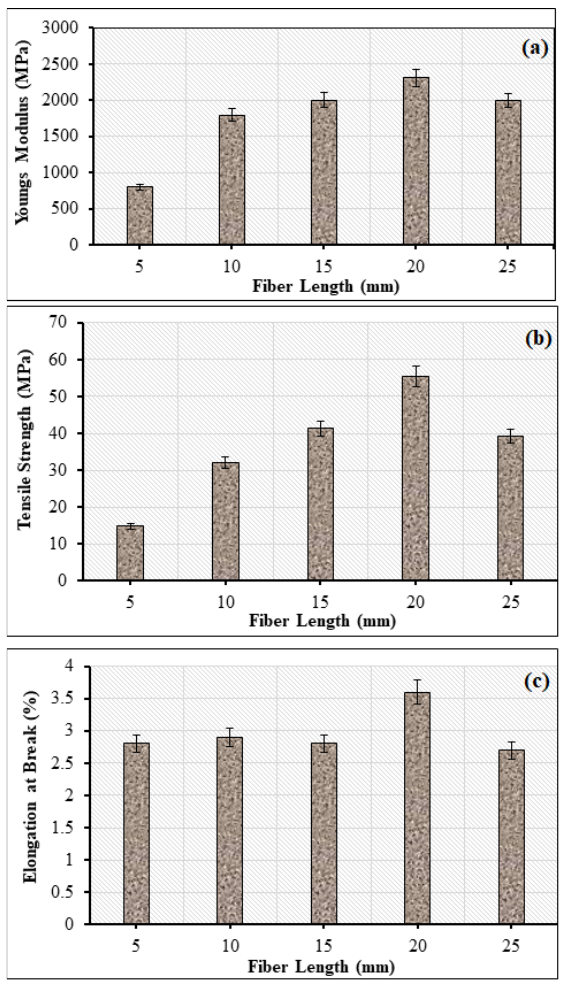
Figure 7. Tensile tests results for ( a ) Young’s modulus vs. fiber length, ( b ) tensile strength vs. fiber length, ( c ) percentage of elongation vs. fiber length.